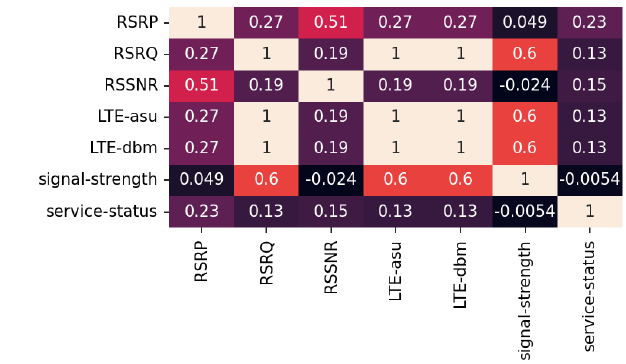
Figure 4. Correlation matrix between radio indicators and service